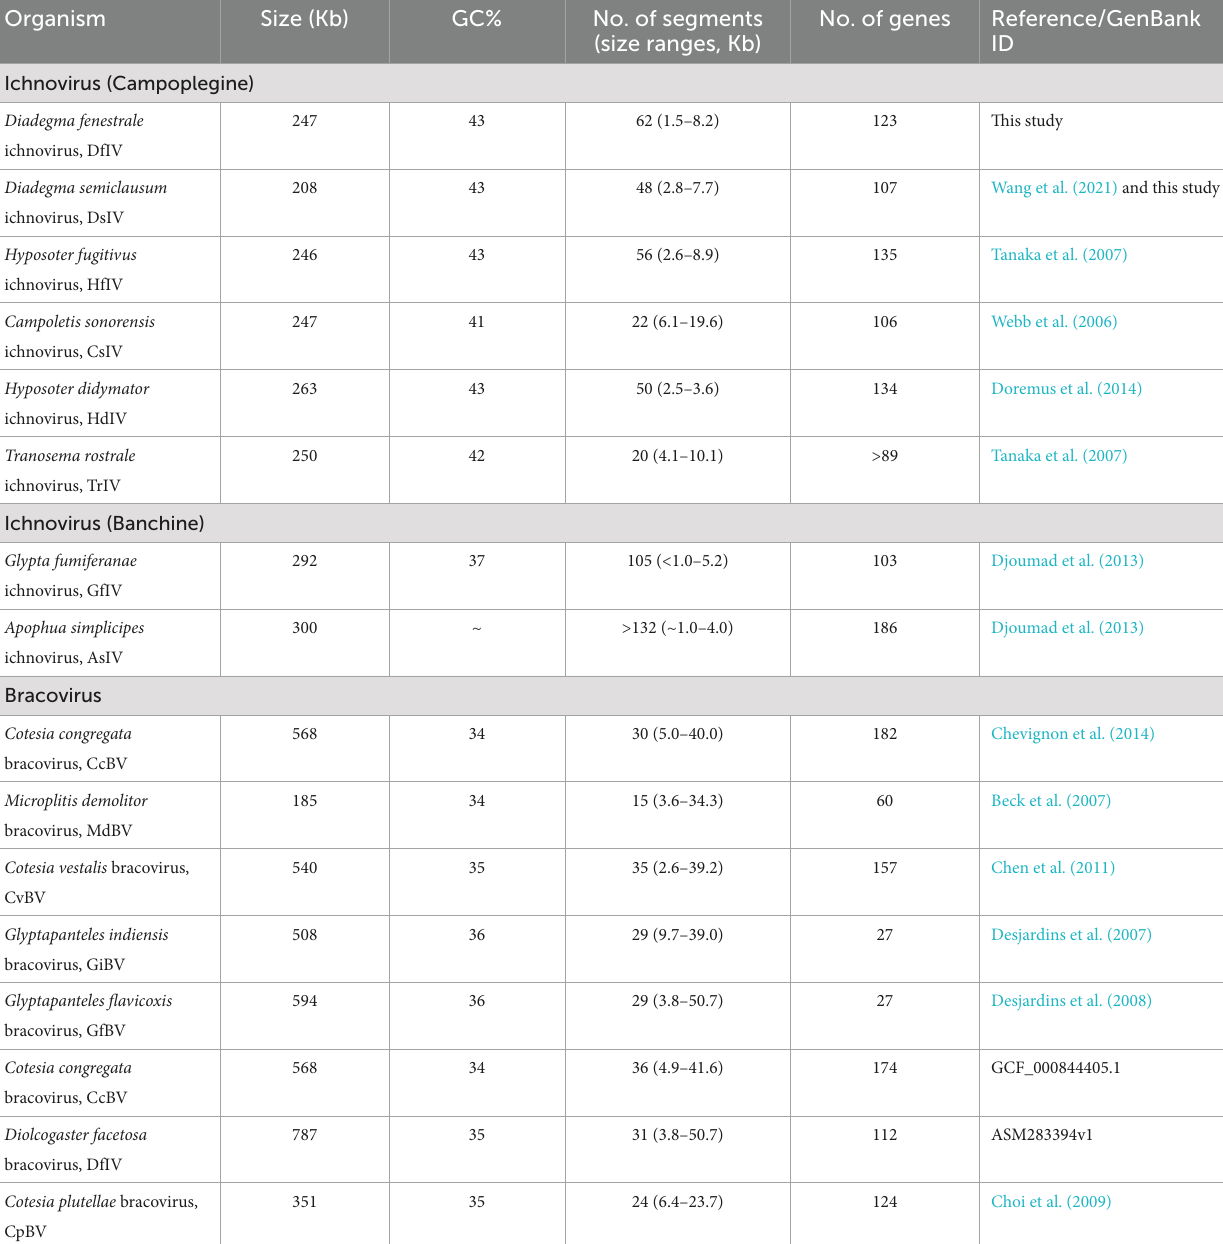
TABLE 1 List of comparable data from diverse ichnoviruses and bracoviruses regarding genome sequence length, gene segment abundance, and number of genes.